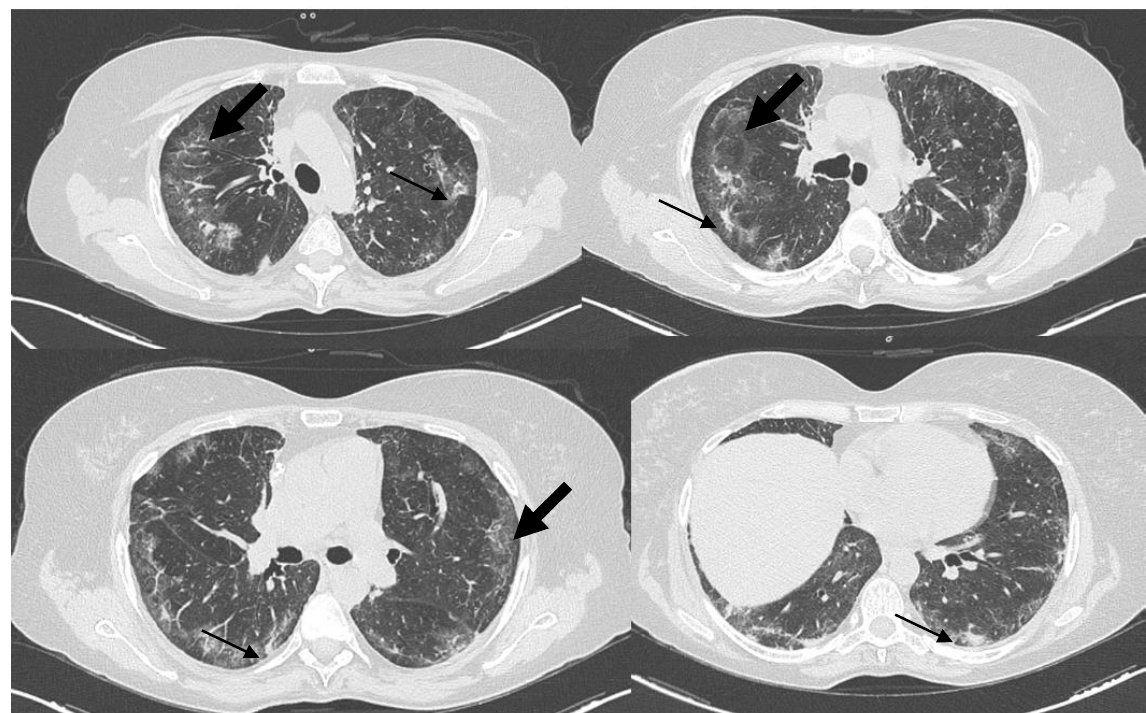
Figure 1. High resolution chest CT (HRCT), on lung window settings, showing an interstitial lung pattern displaying multilobar ground-glass opacities (large arrows); consolidations with traction bronchiectasis (small arrows) in both lungs, with peripheral and posterior distributions; subpleural sparing; and absence of lymphadenopathy for a 50-year-old nonsmoker woman, who was admitted to a general medicine ward of a peripheral hospital, on December 2020, for a 1-month history of increasing dyspnea and dry cough. In her medical history, the patient was treated in 2016 by radiotherapy and chemotherapy for a Non-Hodgkin’s Lymphoma (NHL), which was currently in follow up, and had hypertensive cardiopathy and dyslipidemia, both of which were under drug treatments. The laboratory tests were non-specific: there was a modest increase in white blood cells and CRP, and multiple SARS-CoV-2 PCR tests from nasopharyngeal swabs tested negative. A physical exam revealed a shortness of breath with a 93% oxygen saturation in the ambient air, a respiratory rate of 25 breaths per minute, a heart rate of 85 beats per minute, a blood pressure of 140/80 mmHg, and apyrexia. On an auscultation, fine bilateral and basal teleinspiratory crackles of the lung were revealed. A chest x-ray showed — mainly as a submantellar pattern — bilateral inter- stitial lung involvement plus the elevation of the right emidiaphragm. Thus, in the suspicion of a